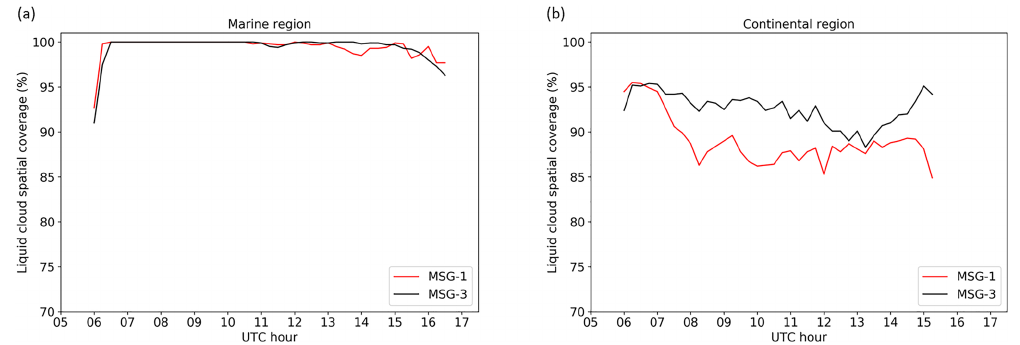
Figure 3. Spatial coverage (%) of the marine (a) and continental (b) regions with liquid clouds during 7 and 20 March 2017, respectively, estimated separately from MSG-1 (red lines) and MSG-3 (black lines). The regions are indicated in Fig. 1.